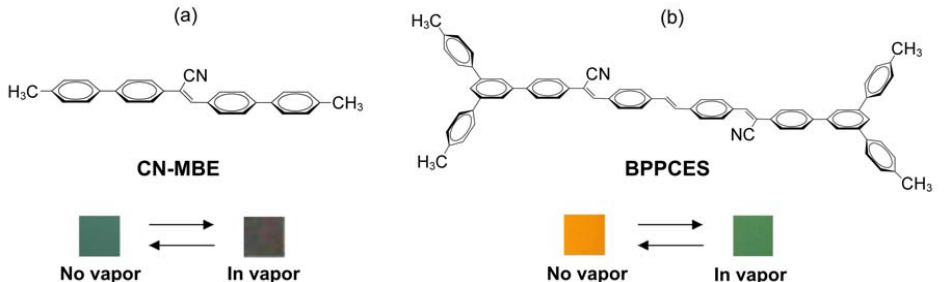
Figure 14. Chemical structures of: a) CN-MBE, and b) BPPCES. The photos show PL color changes of CN-MBE and BPPCES without vapor (left) and in vapor (dichloromethane) (right), respectively. Reproduced with permission from